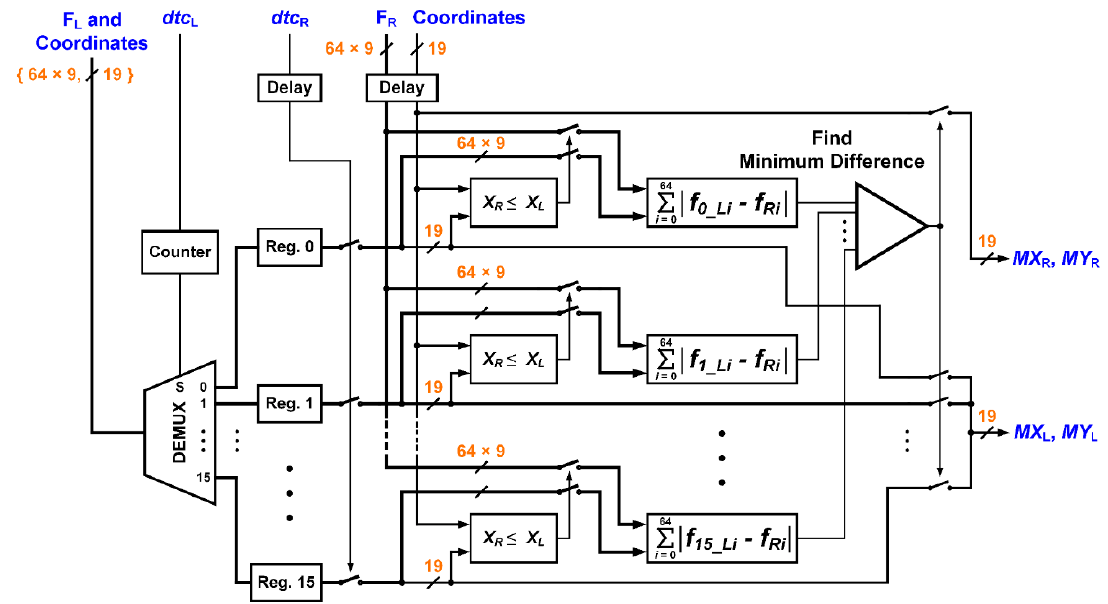
Figure 19. Building blocks of the proposed finite-area parallel (FAP) feature matching for stereo vision.